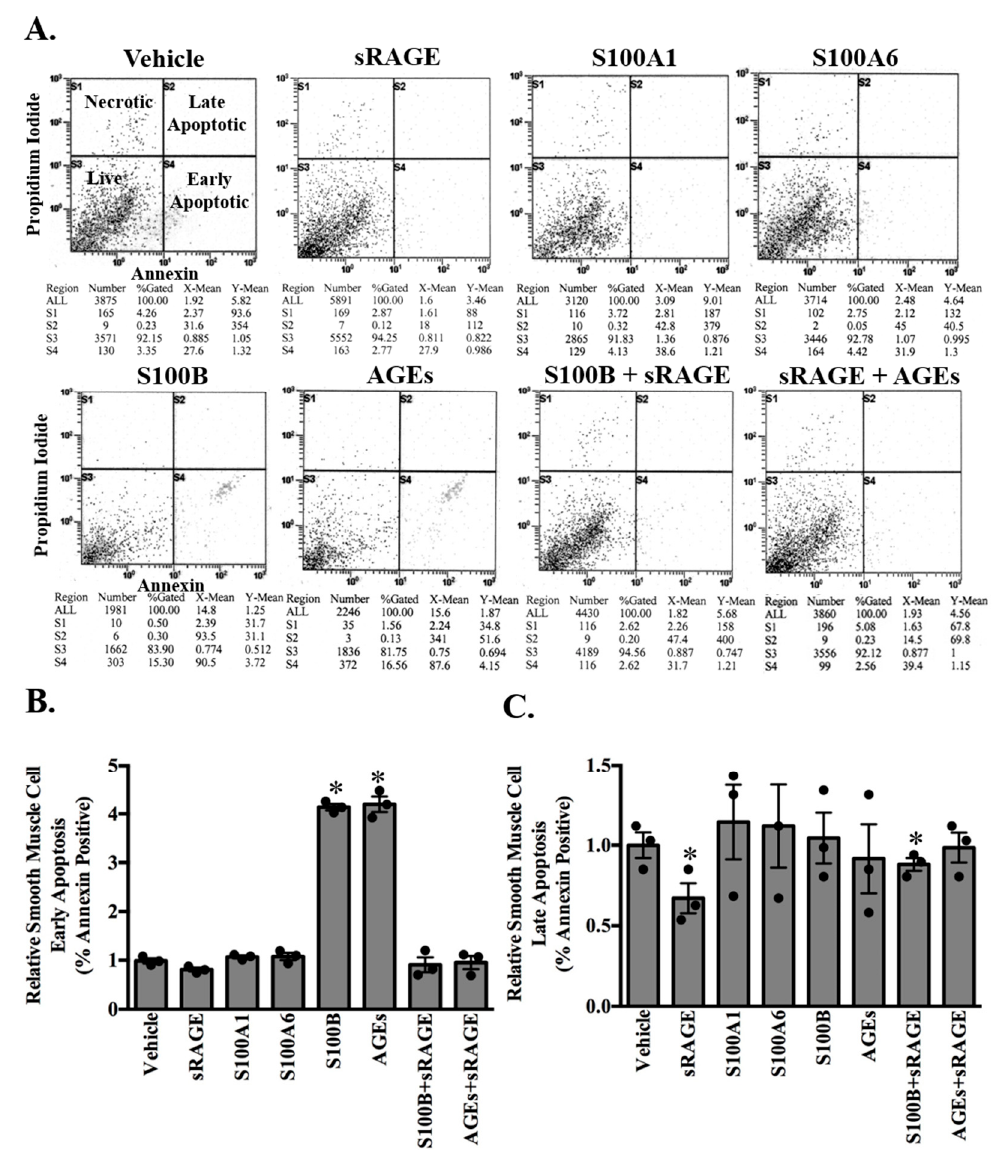
Figure 3. sRAGE inhibits smooth muscle cell apoptosis induced by either S100B or AGEs. Cultured adult rodent abdominal aortic smooth muscle cells were exposed to vehicle (PBS), sRAGE (1.5 ng/mL), S100A1 (10 ng/mL), S100A6 (1.5 ng/mL), AGEs (50 μ g/mL) or S100B (100 pg/mL) alone or in combination with sRAGE (S100B, AGEs) for 24 h. Representative images of apoptosis as determined